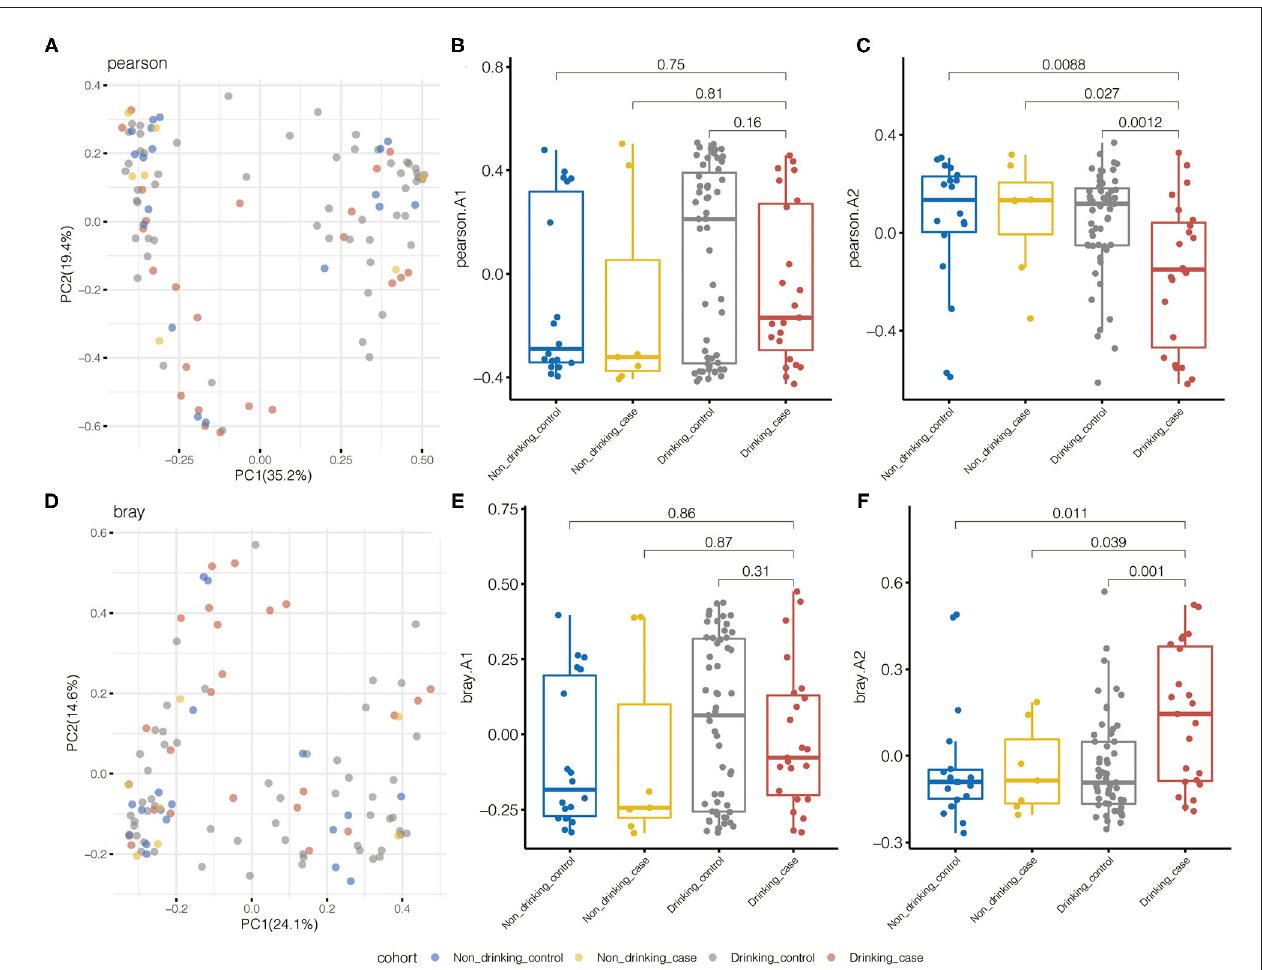
FIGURE 3 | Pearson distance and Bray–Curtis distance illustrated significant differences in the microbial community for species beta diversity. (A) Principal coordinate analysis (PCOA) diagram by the Pearson distance. (B,C) The first and second principal components based on the Pearson distance. (D) PCOA diagram by Bray–Curtis distance. (E,F) The first and second principal components are based on the Bray–Curtis